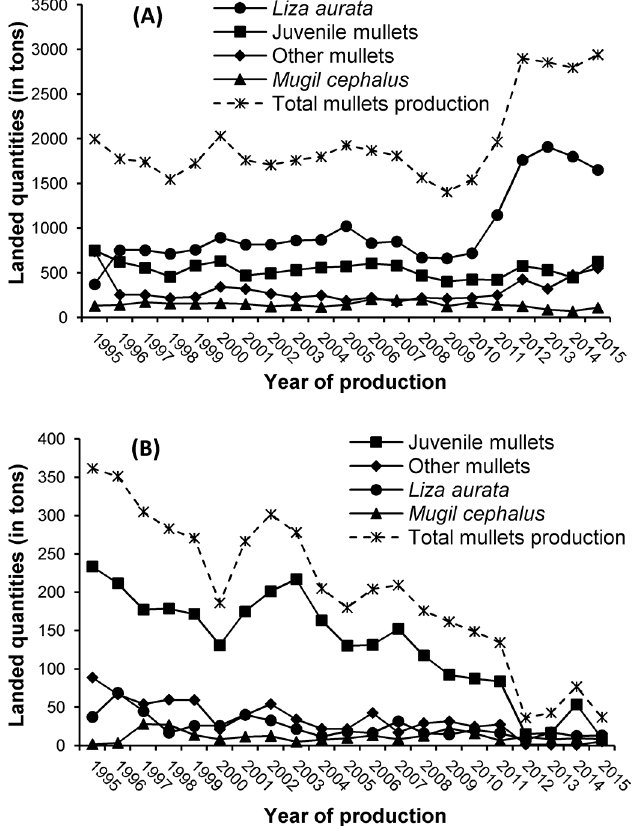
Fig. 4. Evolution of coastal landings (A) and lagoon landings (B) of the total and the major species of mullets ( Liza aurata, juvenile mullets, other mullets, Mugil cephalus ) during period from 1995 to 2015 in Tunisia (graph was built according to the statistics of the national fi shing and aquaculture direction of the Ministry of Agriculture, Water Resources and Fisheries of Tunisian Republic).